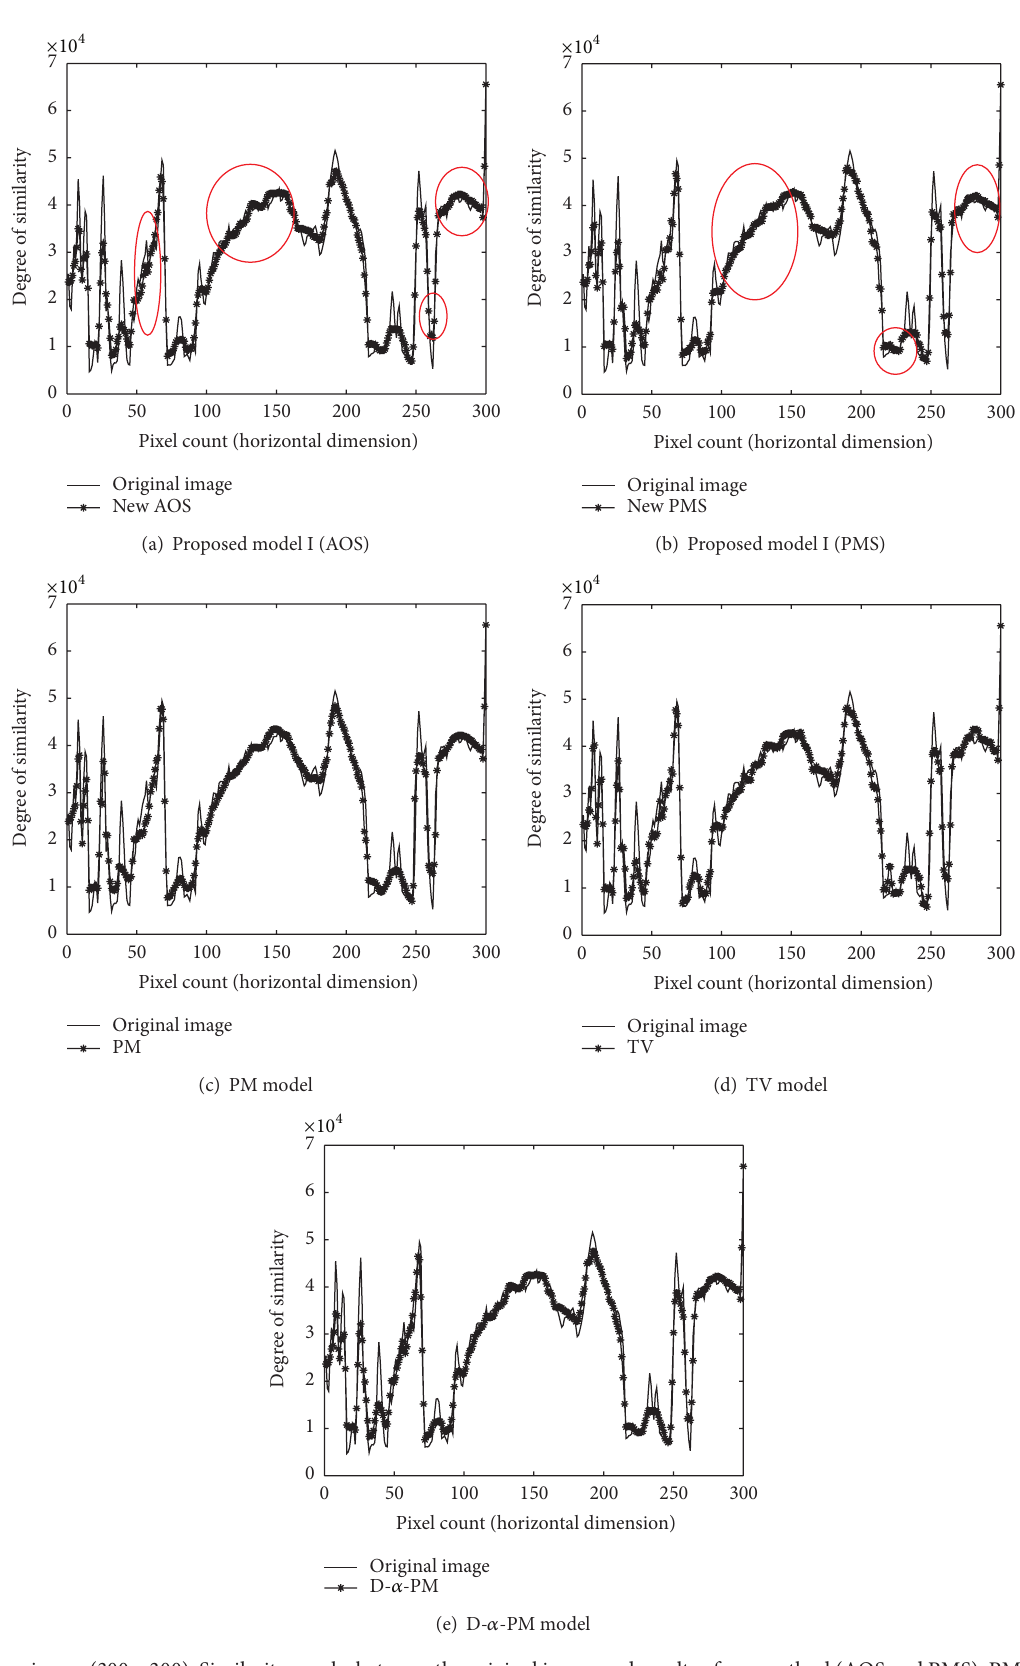
Figure 4: Lena image ( 300×300 ). Similarity graphs between the original image and results of our method (AOS and PMS), PM method, TV method, and D- 𝛼 -PM method,